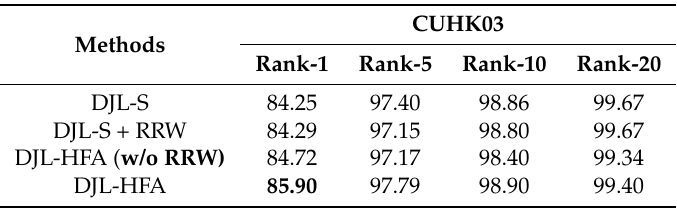
Table 11. Effects of Region Re-Weighting and Hierarchical Feature Aggregation using the base Inception network on CUHK03. Identification accuracy (%) is reported. The best Rank-1 result is marked in